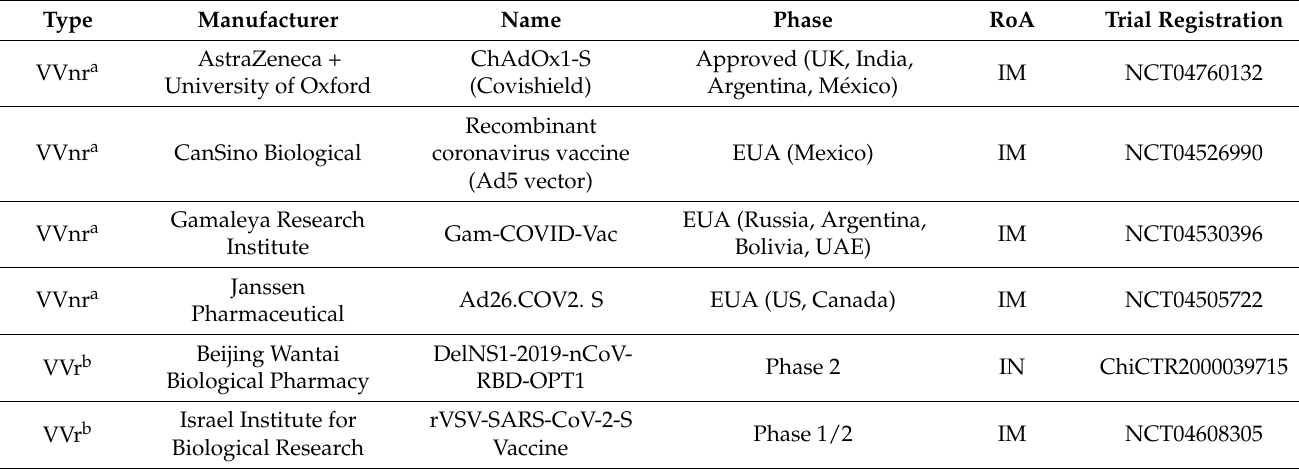
Table 3. Promising COVID-19 viral vector-based vaccine candidates in clinical